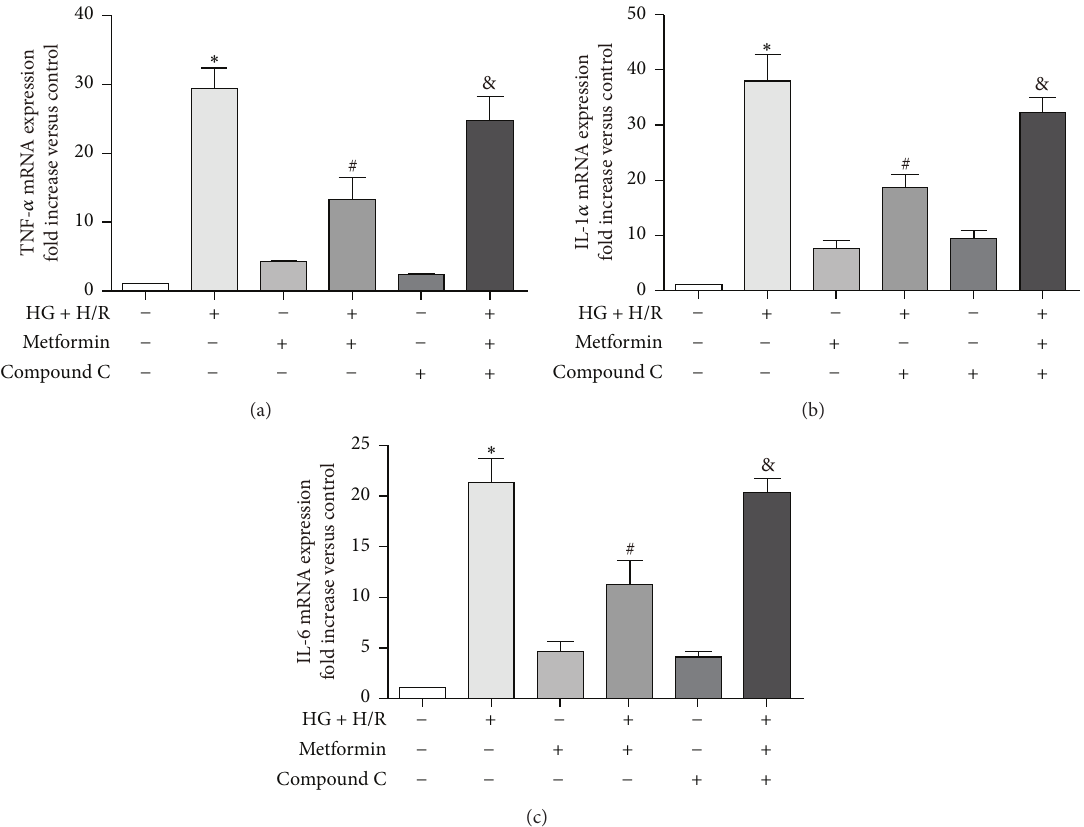
Figure 4: Metformin attenuated HG and H/R injury by inhibiting proinflammatory cytokine expression in cardiac cells. H9C2 cells were treated as described in Figure 3. (a)–(c) Expressions of TNF- 𝛼 , IL-1 𝛼 , and IL-6 mRNA level were measured by real-time PCR. GAPDH was used as the housekeeping gene. Data are shown as means ± SD of 3 independent experiments. ∗ 𝑃 < 0.05 versus control; # 𝑃 < 0.05 versus HG + H/R; & 𝑃 < 0.05 versus metformin + HG +